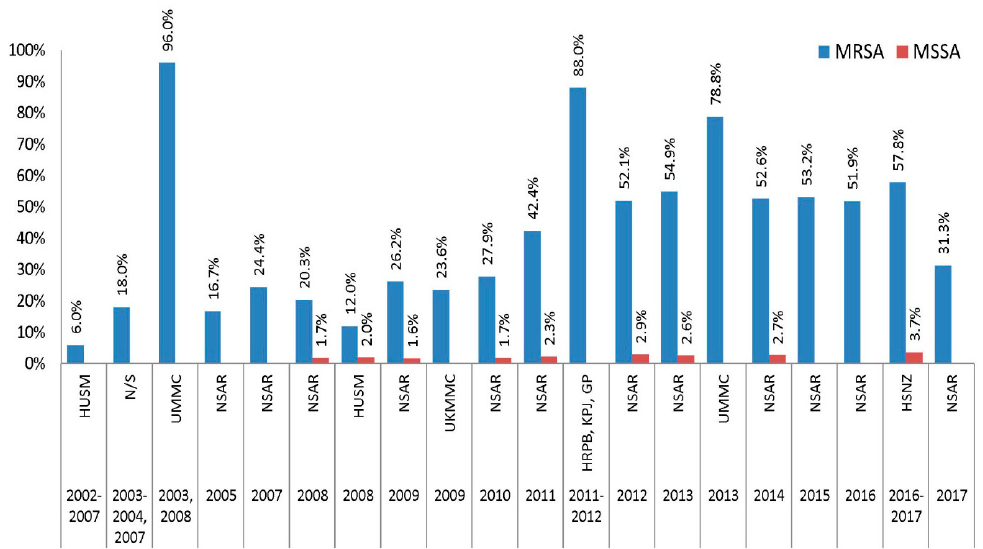
Figure 4. The prevalence of clindamycin resistance in Malaysian S. aureus isolates, 2002–2017. Data from the NSAR reports; HUSM between 2002 and 2007 [15] and in 2008 [19]; not specified